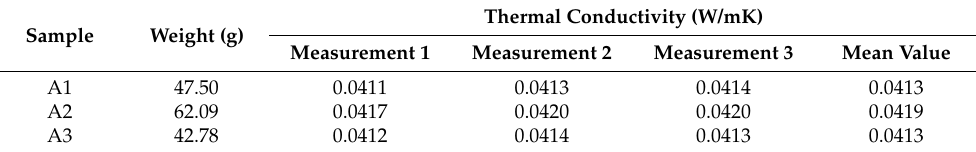
Table 2. Final measurement